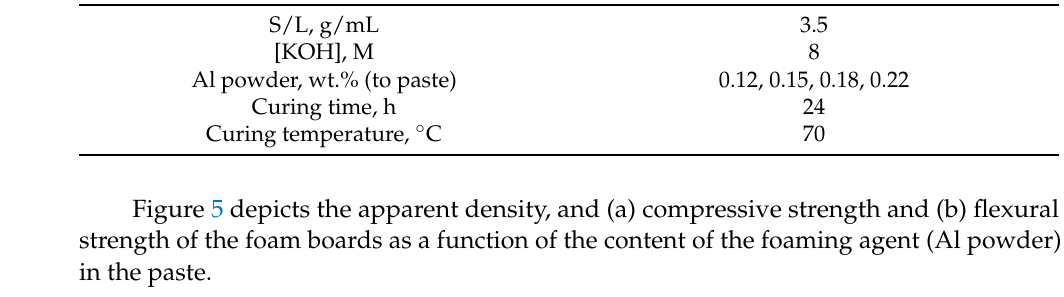
8 of 14 Table 3. Evaluation of optimum produced geopolymer material with S/L ratio (3.5 g/mL) and [KOH]: 8 M. Material Density, kg/m 3 Compressive Strength (after 28 Days), MPa Flexural Strength (after 28 Days), MPa